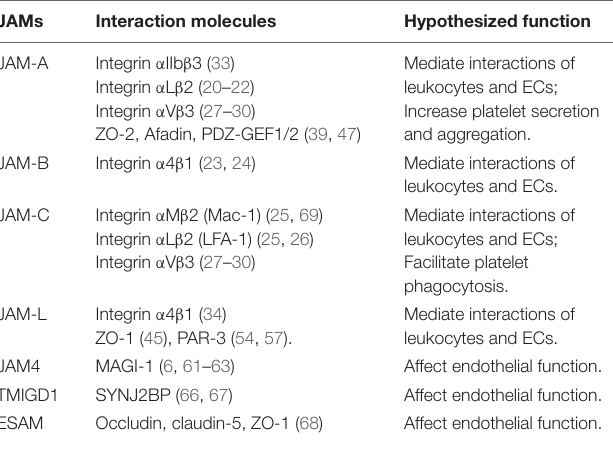
TABLE 1 | Hypothesized atherosclerosis-associated JAMs-interacting proteins. JAMs Interaction molecules Hypothesized